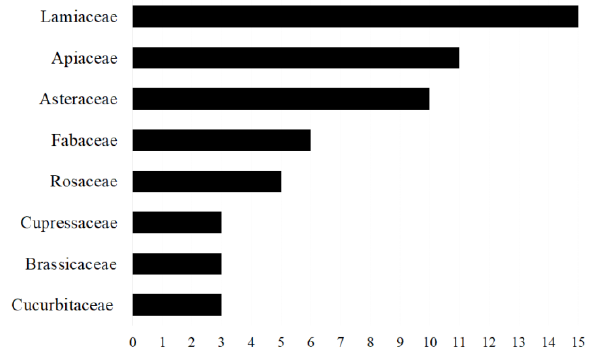
Figure 2. Number of species per family of the most representative botanical